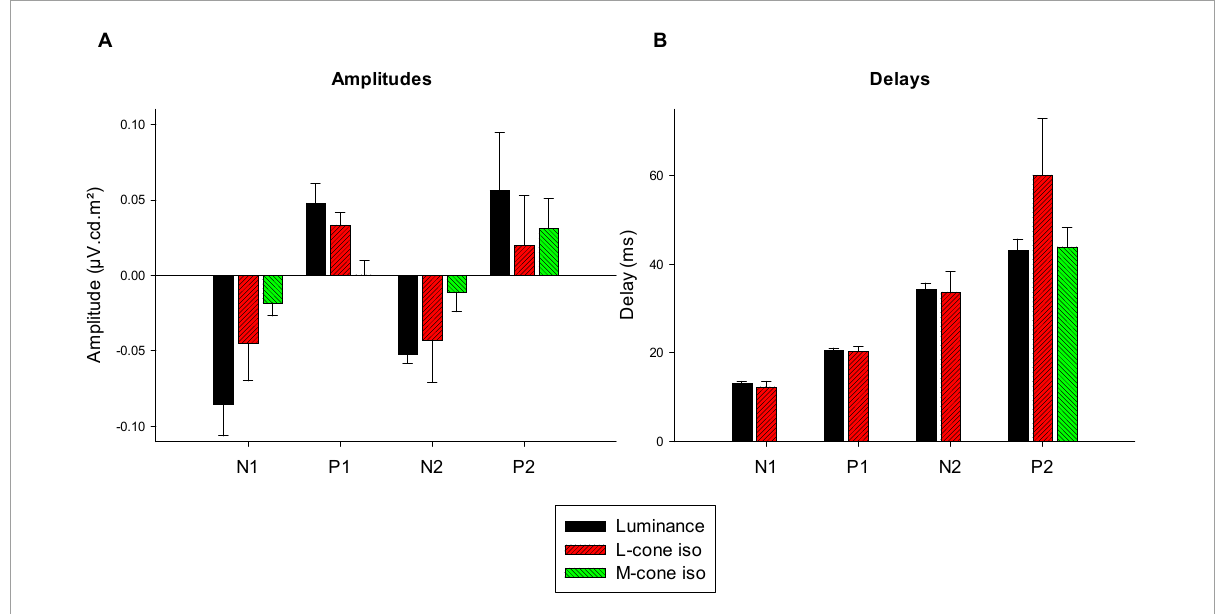
FIGURE11 Amplitudes (A) and delays (B) of the four different components of luminance, L-cone driven and M-cone driven IRFs. Of the M-cone driven IRFs, only P2 was large enough to determine its